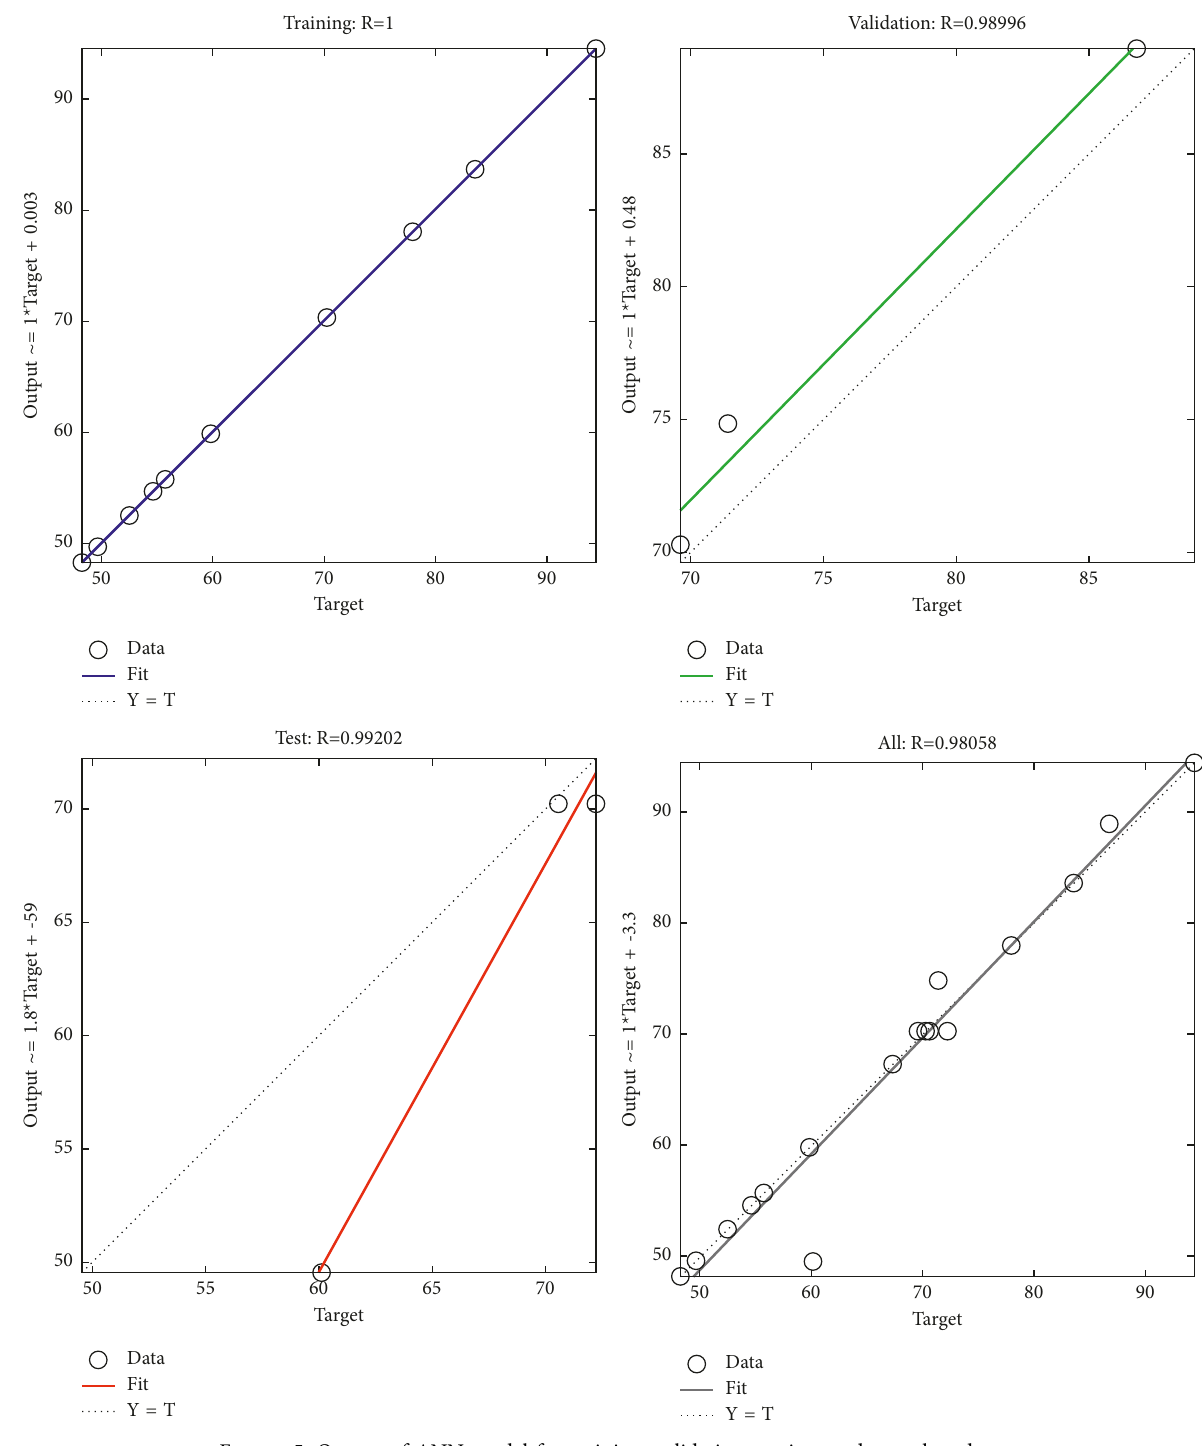
Figure 5: Output of ANN model for training, validation, testing, and complete